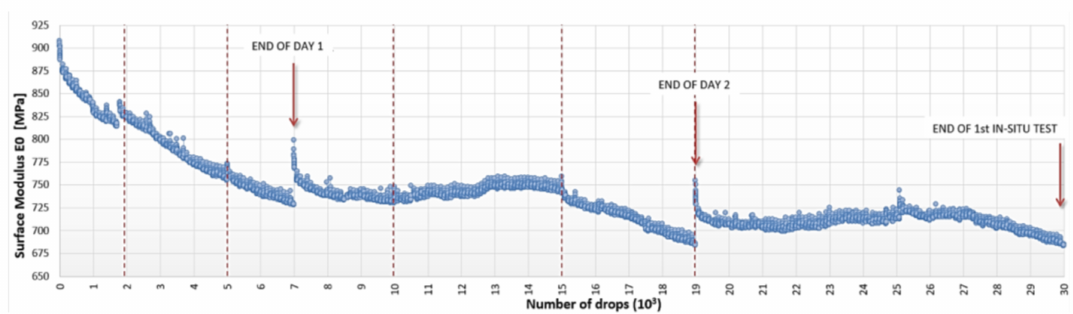
Figure 4. Surface moduli E 0 evolution trend during FFWD test.